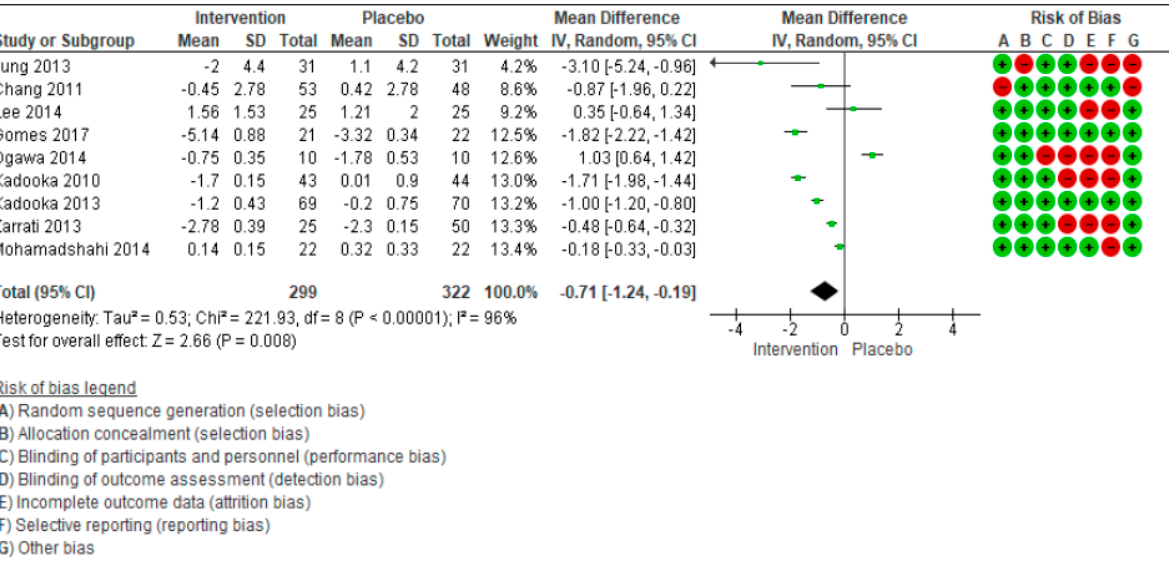
Figure 3. Forest plot for randomized controlled trials of probiotic supplementation included in waist circumference (cm) subgroup meta-analysis ( n = 621). The studies are listed by first author and year. IV = equation that can be estimated by inverse variance (linear, exponential). The square represents the measures of effect (i.e., an odd ratios) for each study; the area of each square is proportional to the study’s weight in the meta-analysis. The horizontal line represents the confidence interval CI) at the 95% level. The diamond represents the meta-analyzed measure of effect; the lateral points of diamond indicate CIs for this estimate. The vertical line represents no effects; if the CI for an individual study overlaps with this line, the given level of confidence for the effect size does not differ from no effect for that study. Risk of bias indicate the level of high and low risk associated with the article, with green signal for low risk and red for high risk of bias.